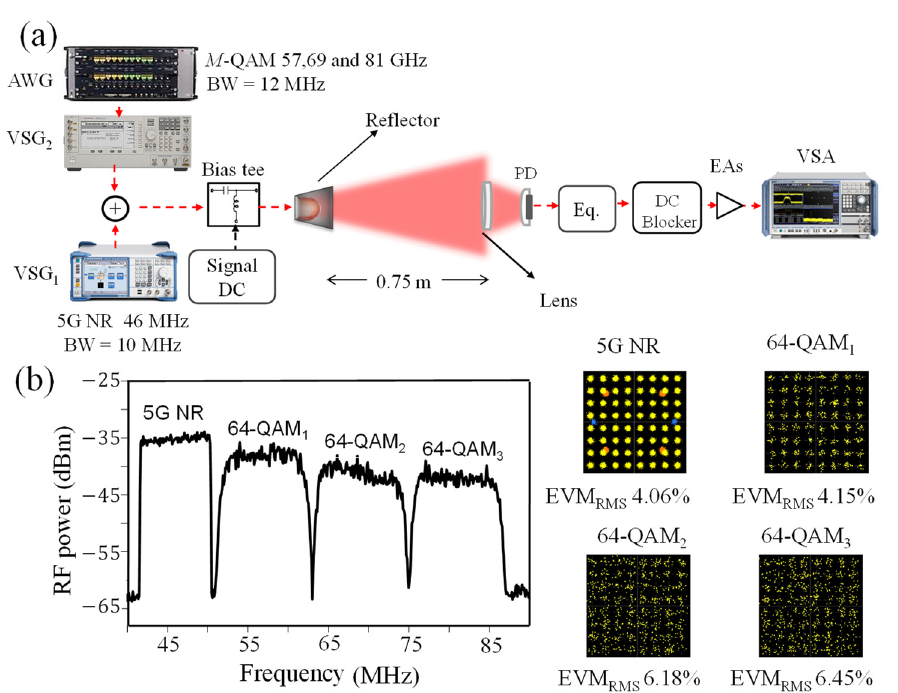
Figure 5. The 4G/5G NR VLC-based access network architecture. ( a ) Block diagram; ( b ) electrical spectrum and EVM RMS at the receiver.